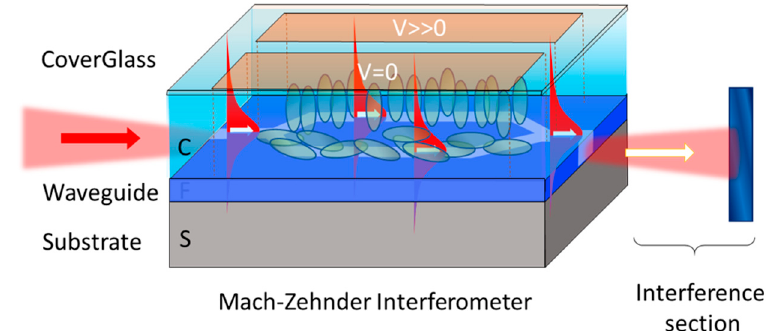
Figure 1. The principle of liquid crystal (LC) cladding tuning. An electric field is applied between the substrate and an external electrode. The effective refractive indices for the TE polarization in both arms of the Mach–Zehnder interferometer (MZI) are tunable. One arm is shown in the relaxed state (V = 0) and the other in a saturated state (V > V sat ). Any intermediate state would be possible.